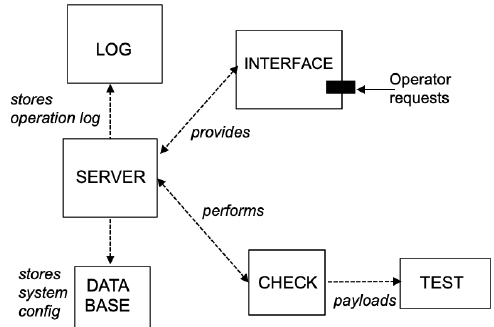
Figure 4. Software functions on the server side concerning